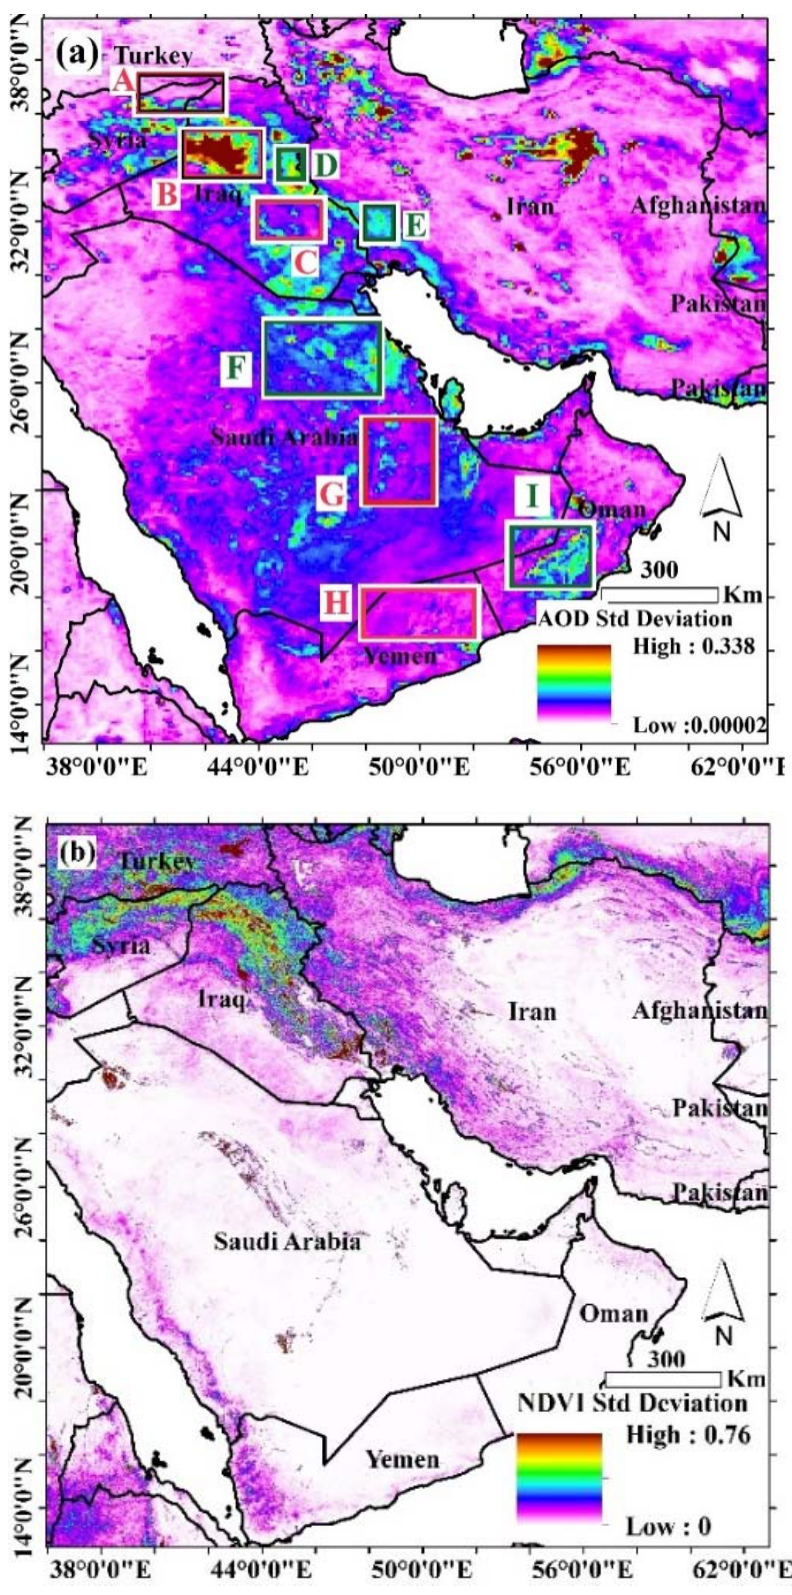
Figure 2. ( a ) Inter-annual MODIS Terra AOD standard deviation between 2000 and 2019 and ( b ) inter- annual standard deviation of NDVI extracted based on 16-day MODIS NDVI products. Highlighted boxes in the left panel indicate areas exhibiting varying relationships between AOD and